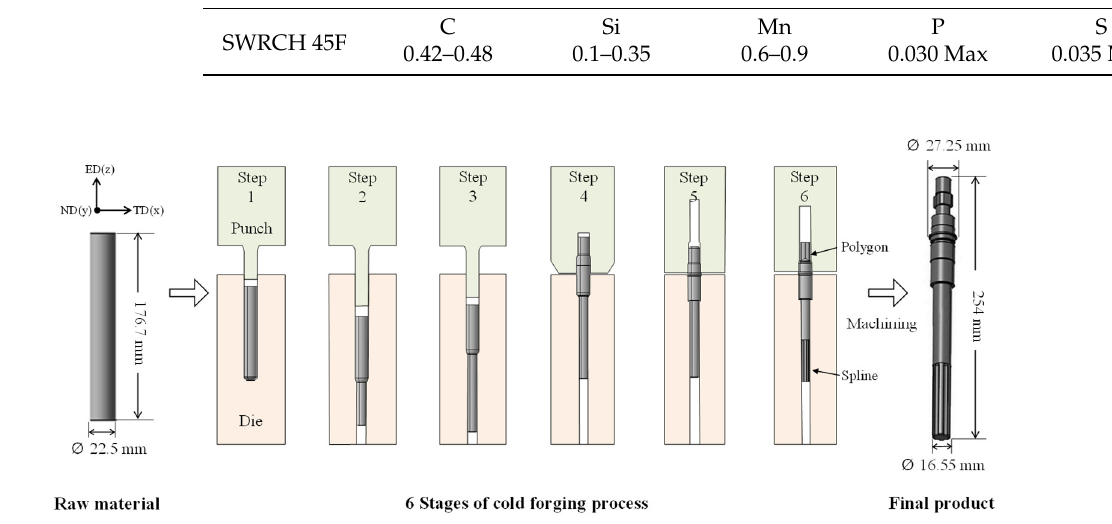
Figure 1. Schematic of the multi-stage cold forging process.